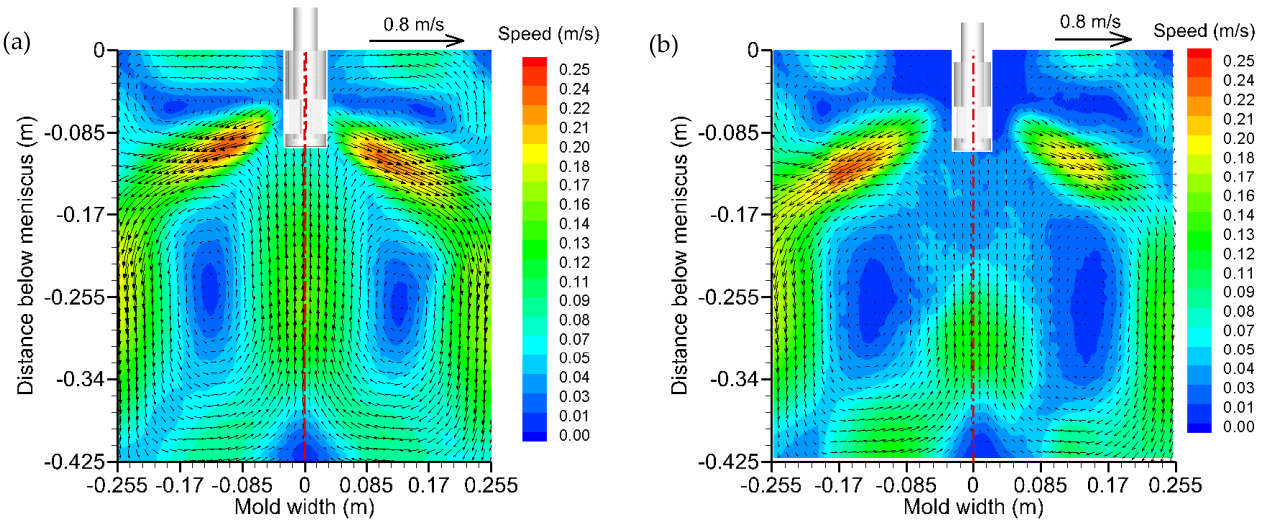
Figure 6. The influence of oil added to the liquid level on the flow field in the mold: ( a ) no oil; ( b ) oil thickness 3 mm.